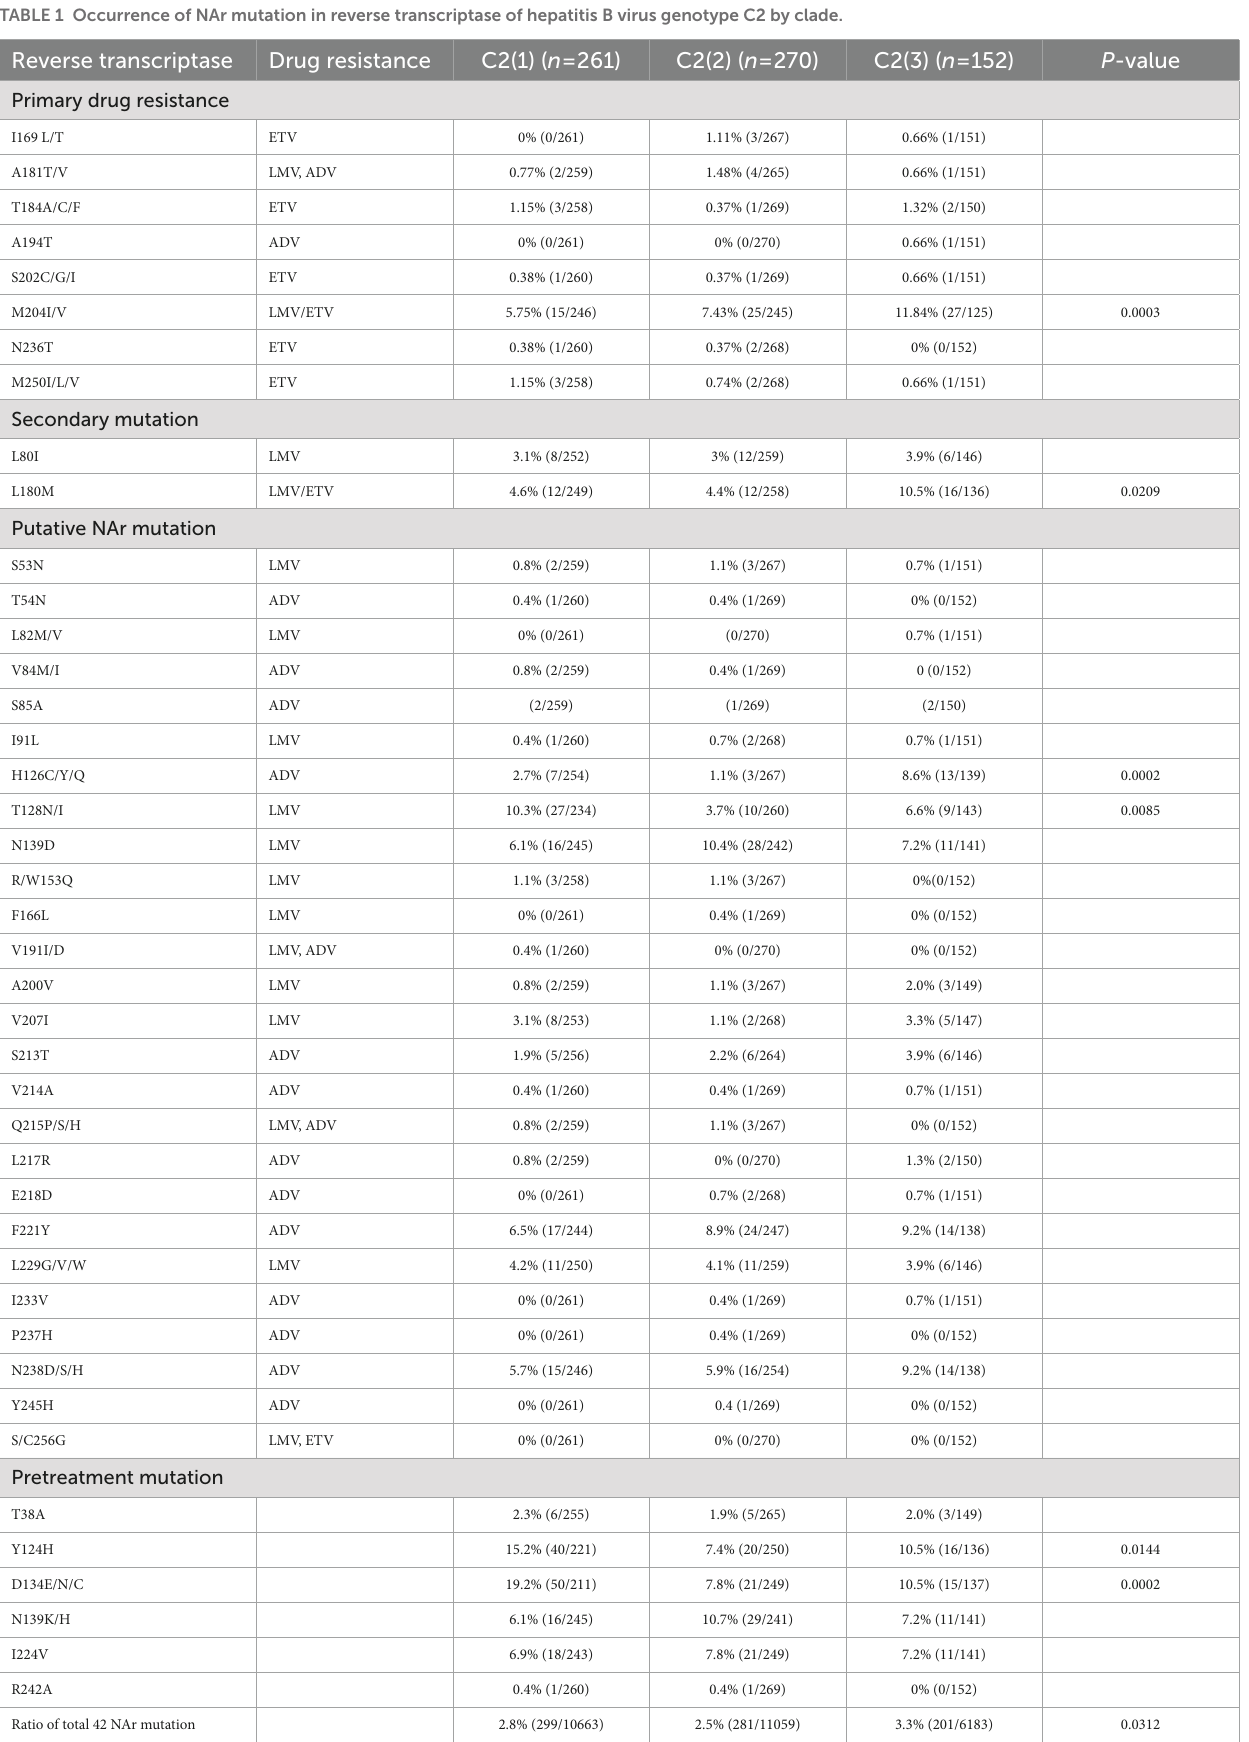
TABLE 1 Occurrence of NAr mutation in reverse transcriptase of hepatitis B virus genotype C2 by clade. Reverse